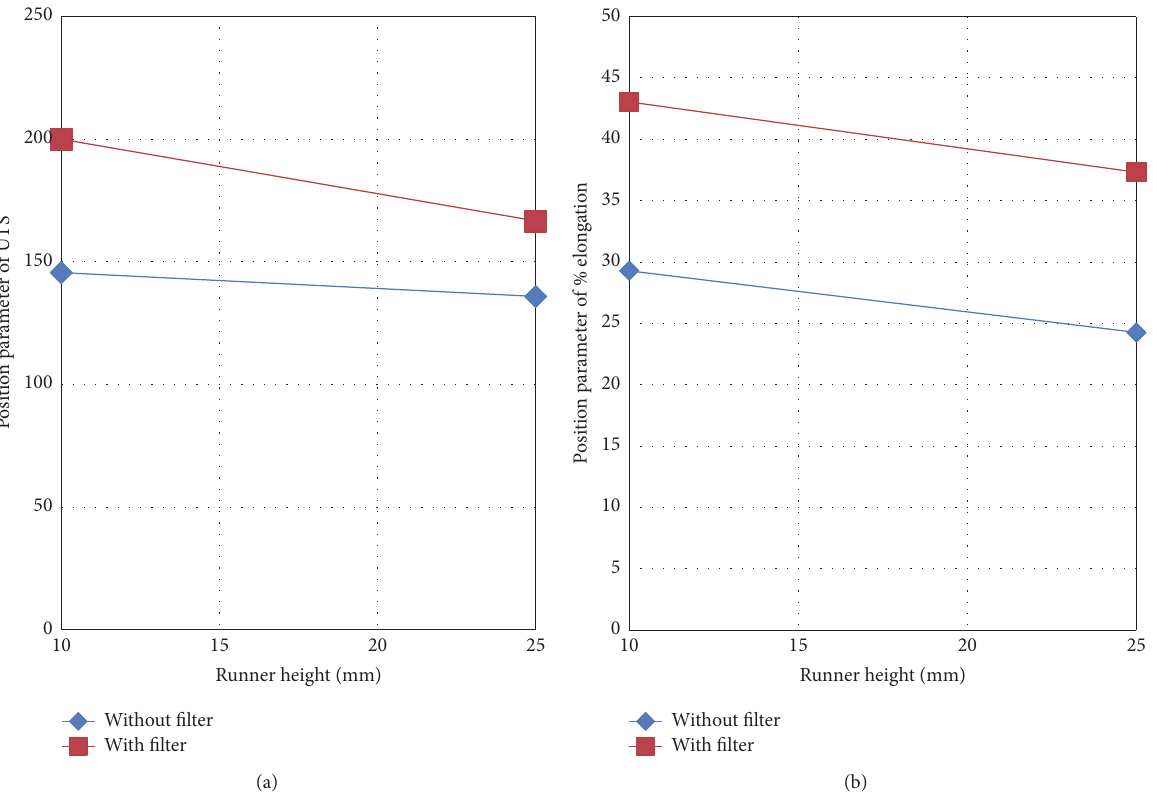
the UTS by about 56%. Conversely, a rise of such modulus of about 109% was achieved through the use of filters while keeping the runner height at 25